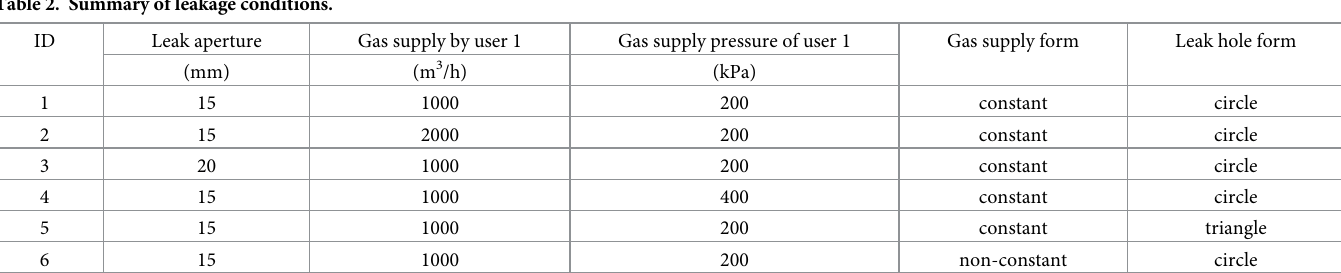
Table 2. Summary of leakage